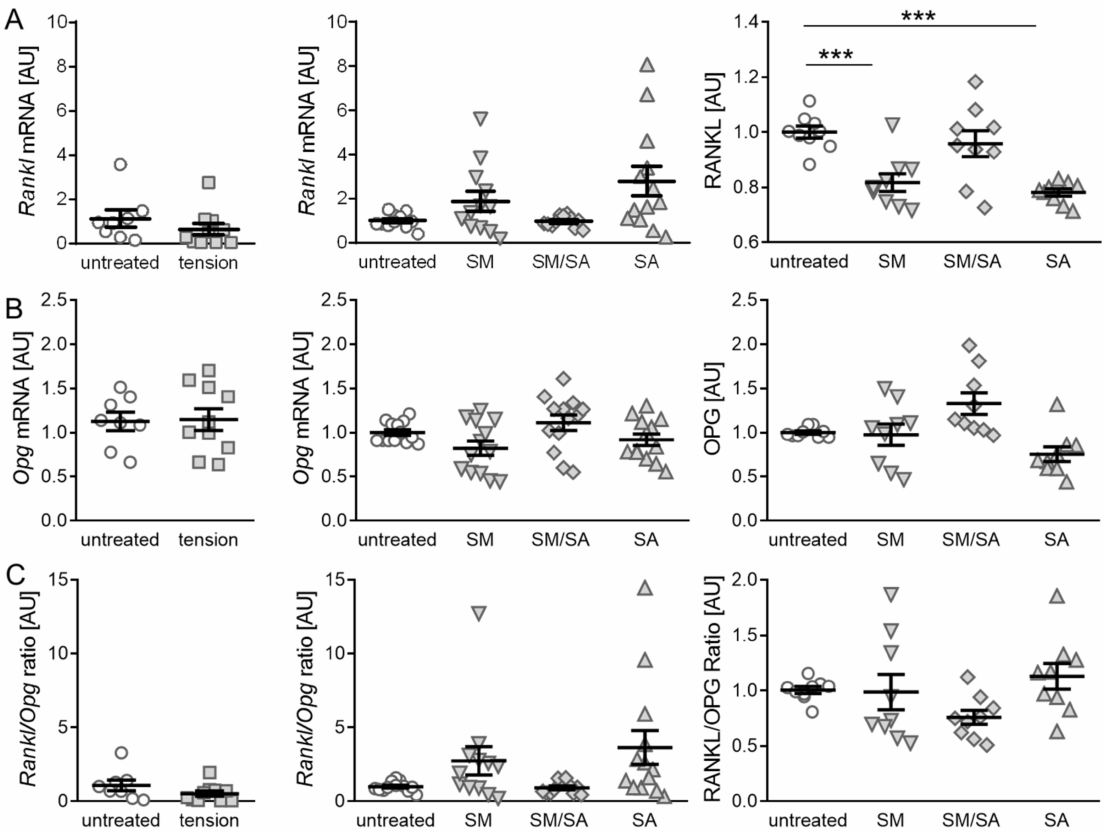
Figure 5. Synovial-fibroblast mediated expression of RANKL and OPG induced by various tensile loading protocols. The gene and protein expression of RANKL ( A ) and the corresponding decoy receptor OPG ( B ), as well as the RANKL/OPG ratio ( C ) after the short high-frequency tensile strain or prolonged tensile strain. AU: Arbitrary units; SM: Moderate; SM/SA: Intermediate; SA: Advanced. n ≥ 6; *** p ≤